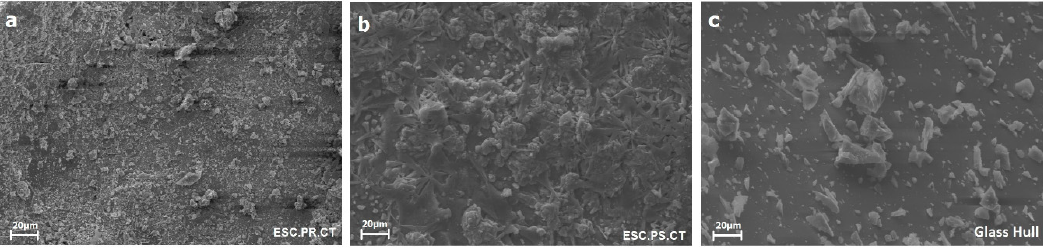
Figure 2. SEM images for ( a ) slag 1, ( b ) slag 2, and ( c ) glass cullet.